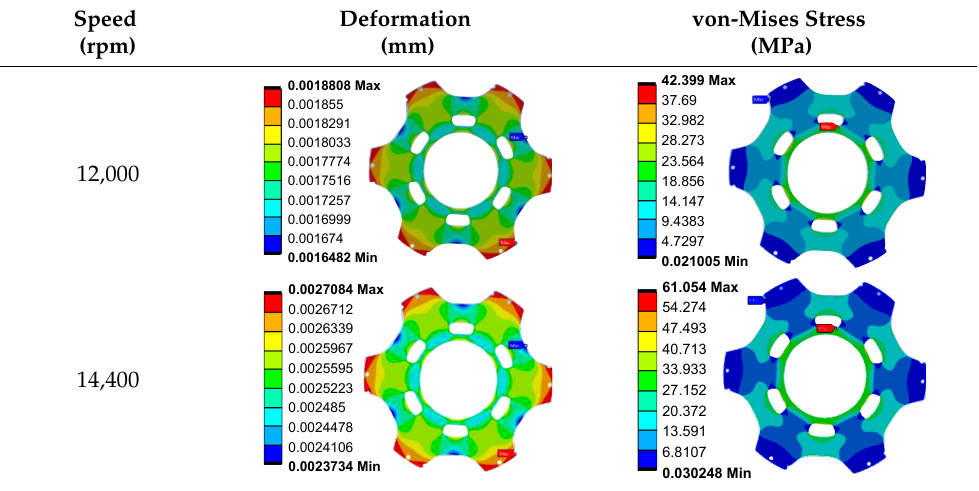
Table 15. Rotor lamination deformation and stress analysis.